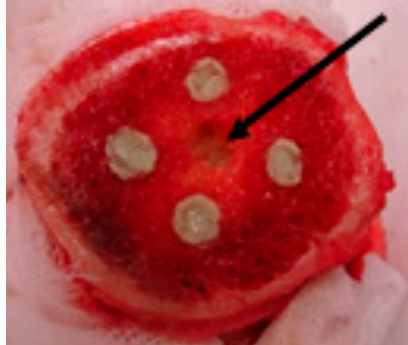
Figure 3. Femur head with inserted implants prepared from poly(methyl methacrylate)-based bone cement (Palacos®r, Wehrheim, Germany) loaded with a peptide and from plain bone cement. Bacteria that were pipetted to the hole between them (arrow) infiltrated through the spongy part of the bone towards the implants, adhered to them and subsequently either formed a biofilm on their surfaces or did not (example representative of the experiments).